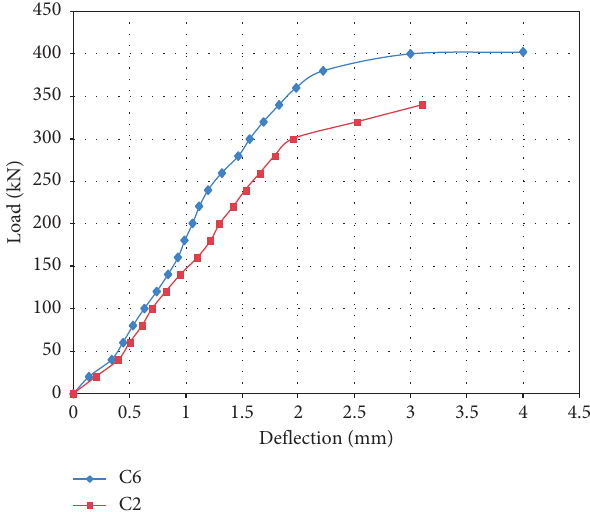
Figure 11: Load-deflection curve of corbels with 100% weight fractions of replacement aggregate for concrete strength 28 and 44.3MPa and a/d ratio